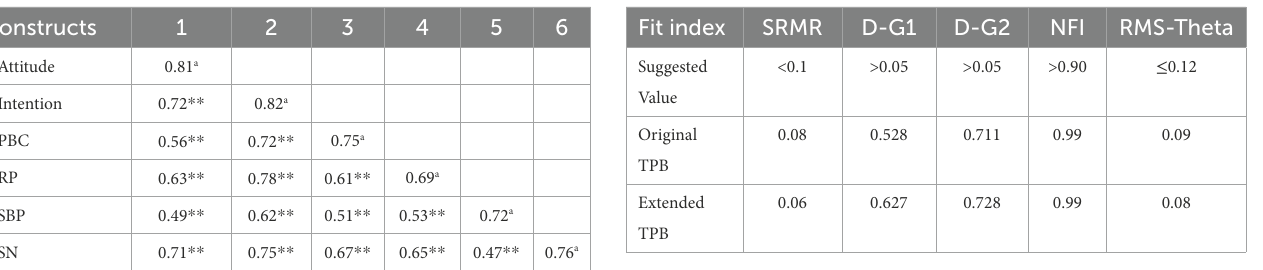
TABLE 5 Summary of goodness of fit indices for the measurement